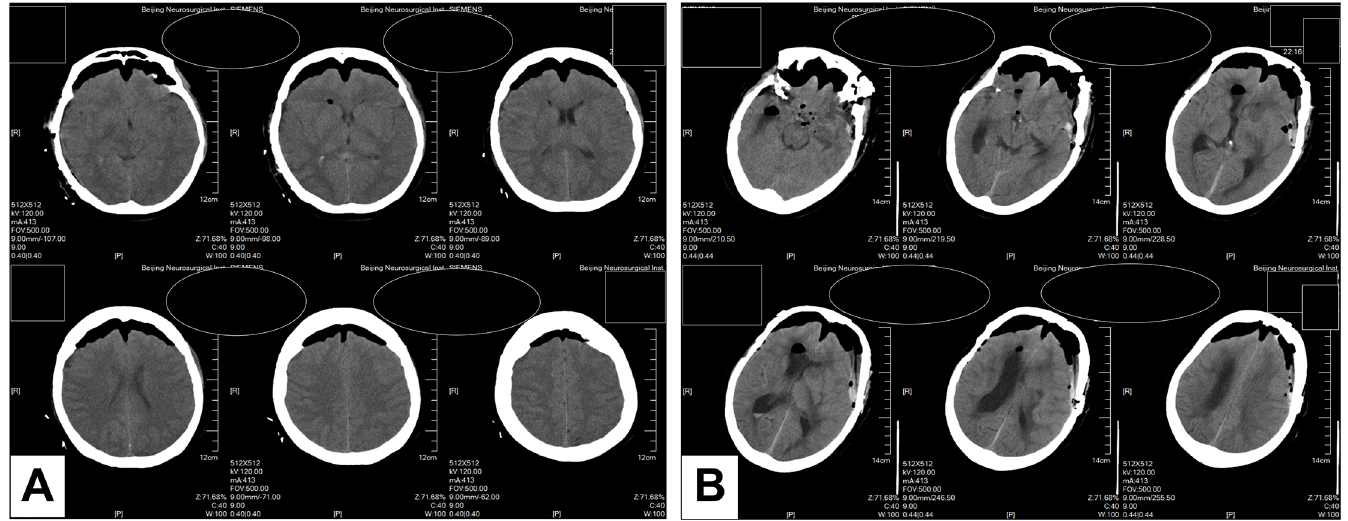
Fig 1. Example CT scans identified as bi-frontal pneumocephalus (A) and “Mount Fuji sign” (B). Patients name and medical record number are masked. Bi-frontal pneumocephalus (A) was defined as complying with all three: 1) subdural areas of hypoattenuation were bilaterally presented in frontal region; 2) low attenuation mass existed in at least four serial axial slices (1 cm thickness); and 3) the maximal displacement of the frontal lobe from the dura was more than 1 cm at least in one slice. “Mount Fuji sign” (B) was identified by bilateral subdural hypoattenuating collections, collapsed frontal lobes and widening of the interhemispheric space between the tips of the frontal